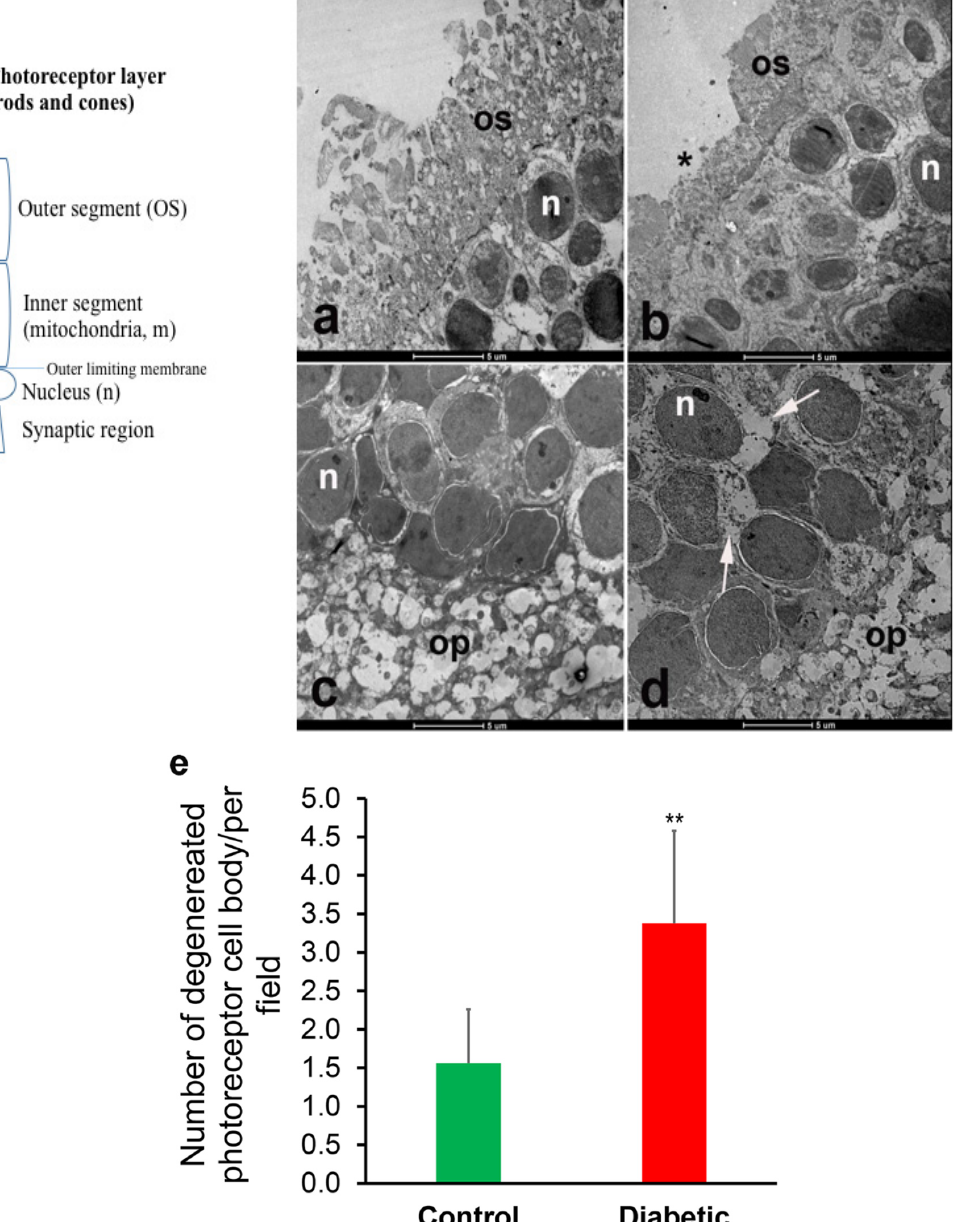
Figure 1. Representative transmission electron micrographs of the retina of non-diabetic ( a , c ) and diabetic ( b , d ) rats. Micrographs ( a , b ) are representatives of the outer segment (OS), the external limiting membrane and part of the outer nuclear layer of the photoreceptor layer. Micrographs ( c , d ) are representatives of the outer nuclear layer of the retina. The outer segment of the photoreceptor layer (OS) is significantly thinner in the diabetic rat retina ( b ). The degeneration of cells of the outer nuclear layer is also conspicuous in the diabetic rat retina (( d ), arrows); n = 6 independent experiments. n, nucleus in the outer nuclear layer; asterisk = outer segment, op = outer plexiform layer. Scale bar = 5 µ m. ( e ) shows the morphometric analysis of the number of degenerated photoreceptor cell bodies in the control versus in the diabetic rat retina. ** p < 0.05 (control versus